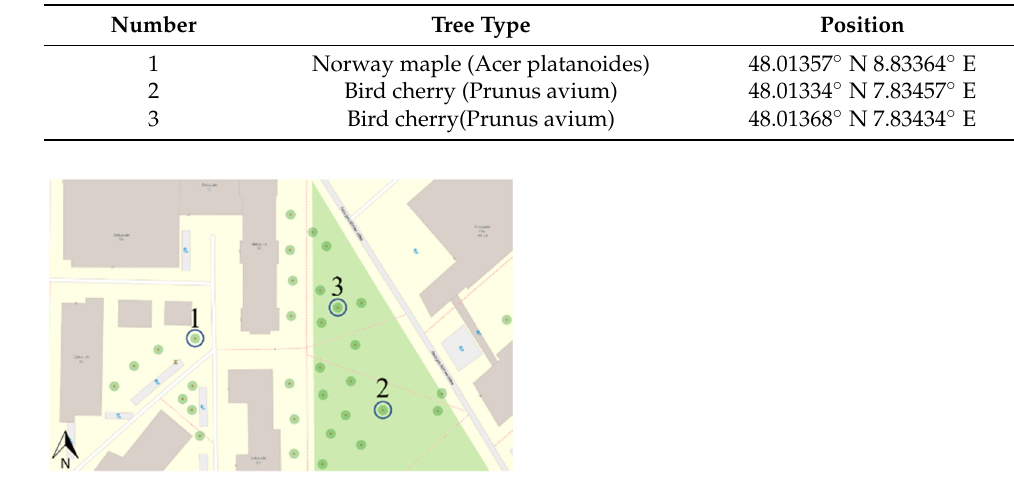
Figure 3. Marked position of the trees that were considered for the experiment, numbered from 1 to 3 (modified map from openstreetmap.org accessed on 10 January 2022).